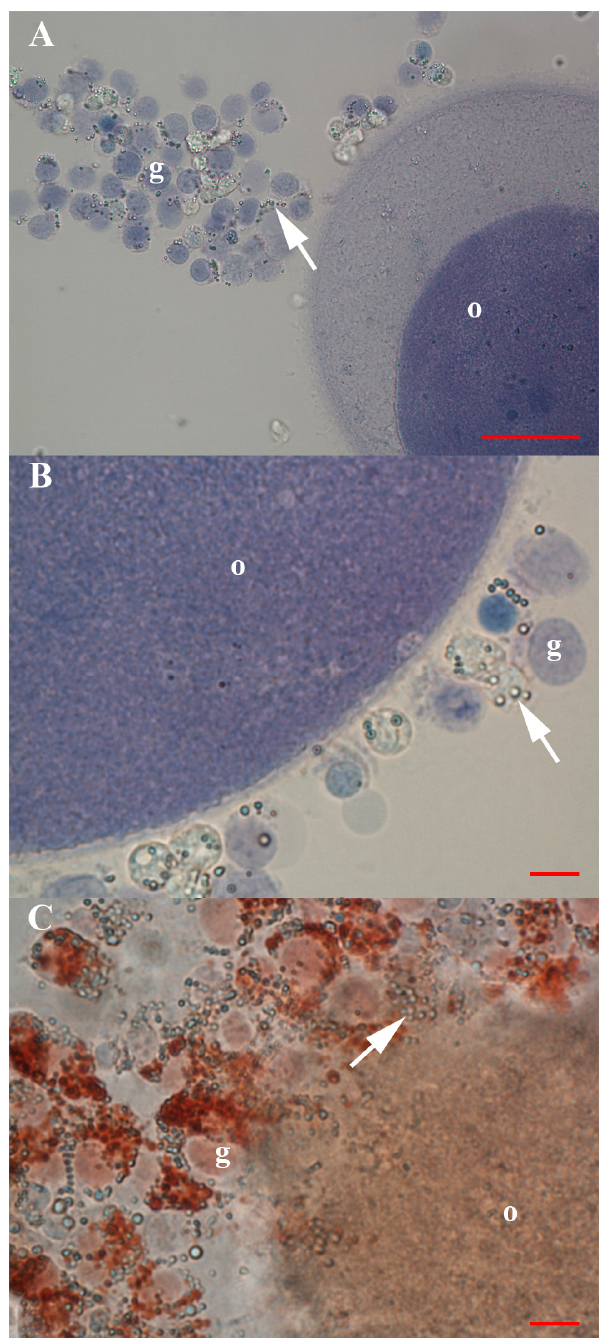
Figure 4. Oocytes that were isolated from the normal ovarian tissue prior to the cell culture and surrounded by follicular (granulosa) cells and a similar population of VSEL-like stem cells (arrows) with diameters of up to 5 μ m among them. ( A ) Dead oocyte surrounded by an uneven zona pellucida and granulosa cells (live and dead) attached to it after Trypan Blue staining; among granulosa cells, there was a population of VSEL-like stem cells (arrow). ( B ) Dead oocyte surrounded by a very thin zona pellucida and granulosa cells (live and dead) attached to it after Trypan Blue staining; among granulosa cells, there was a population of VSEL-like stem cells (arrow). ( C ) Live oocyte surrounded by a mass of granulosa cells (live and dead) after Neutral Red staining; among granulosa cells, there was a population of VSEL-like stem cells (arrow). Legend: o—oocyte; g—granulosa cells; blue—dead cells after Trypan Blue staining; red—live cells after Neutral Red staining. Red Bar: 10 µ m for B, C; 50 µ m for